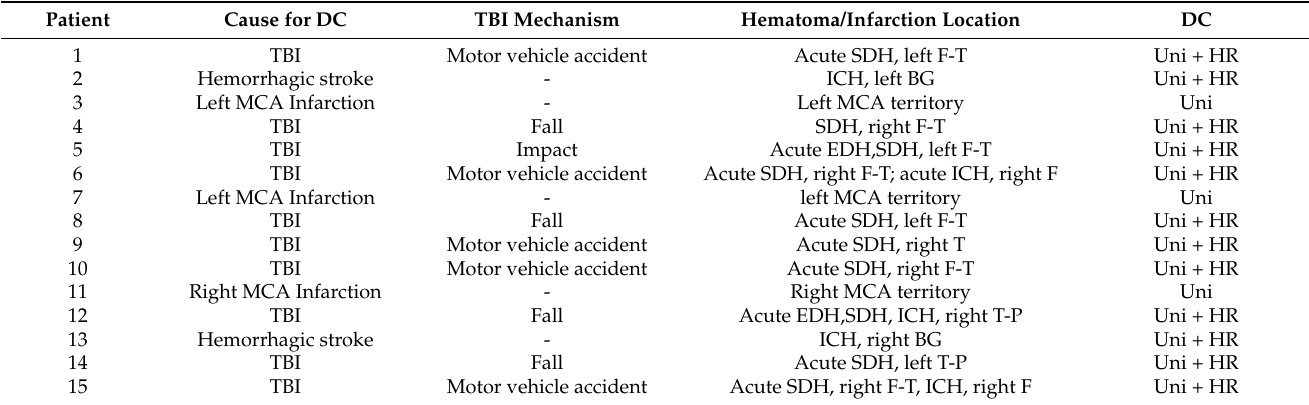
Table 1. Demographic data of 15